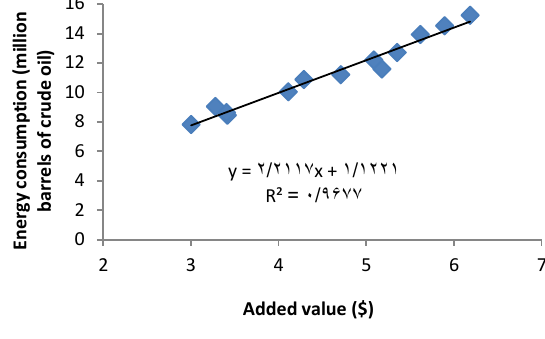
Figure 6. Variations of the energy consumption versus the added